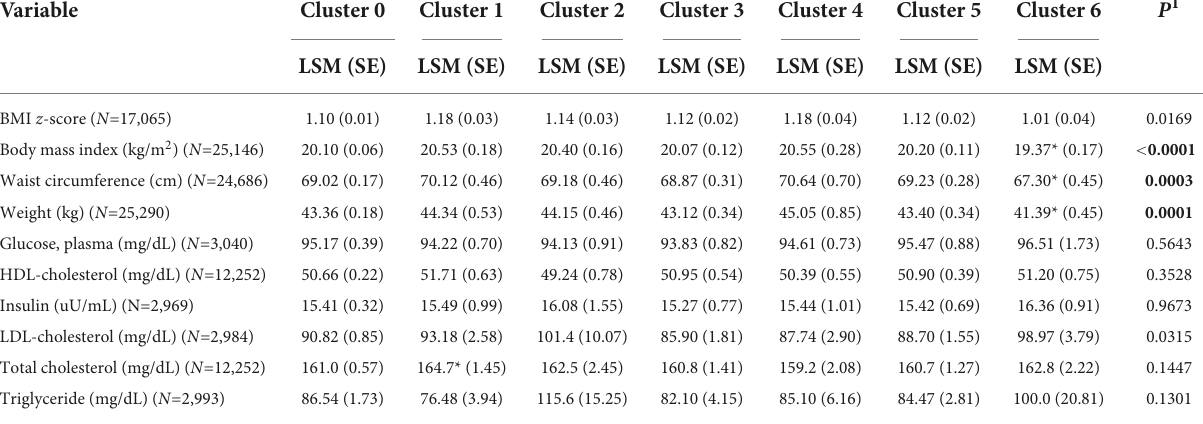
TABLE 5 Least square mean anthropometrics and biomarkers by potato cluster in American children and adolescents. Variable